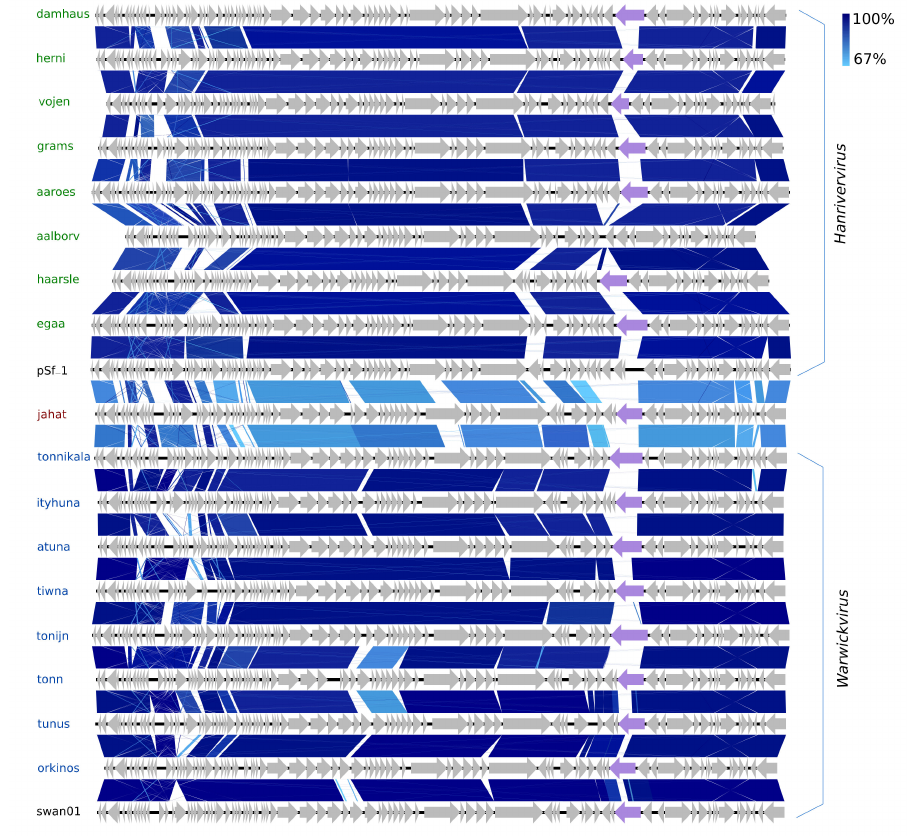
Figure 5. Pairwise alignment of the new Hanrivervirus phages (green text) and type species pSf-1 (black text), the new Warwickvirus phages (blue text), and type species swan01 (black text) and Jahat (brown text); the color bars between genomes indicate percent pairwise similarity (Easyfig, BlASTn). Genomes have been modified to have similar starting points. Coloured genes (purple) code for a putative tail